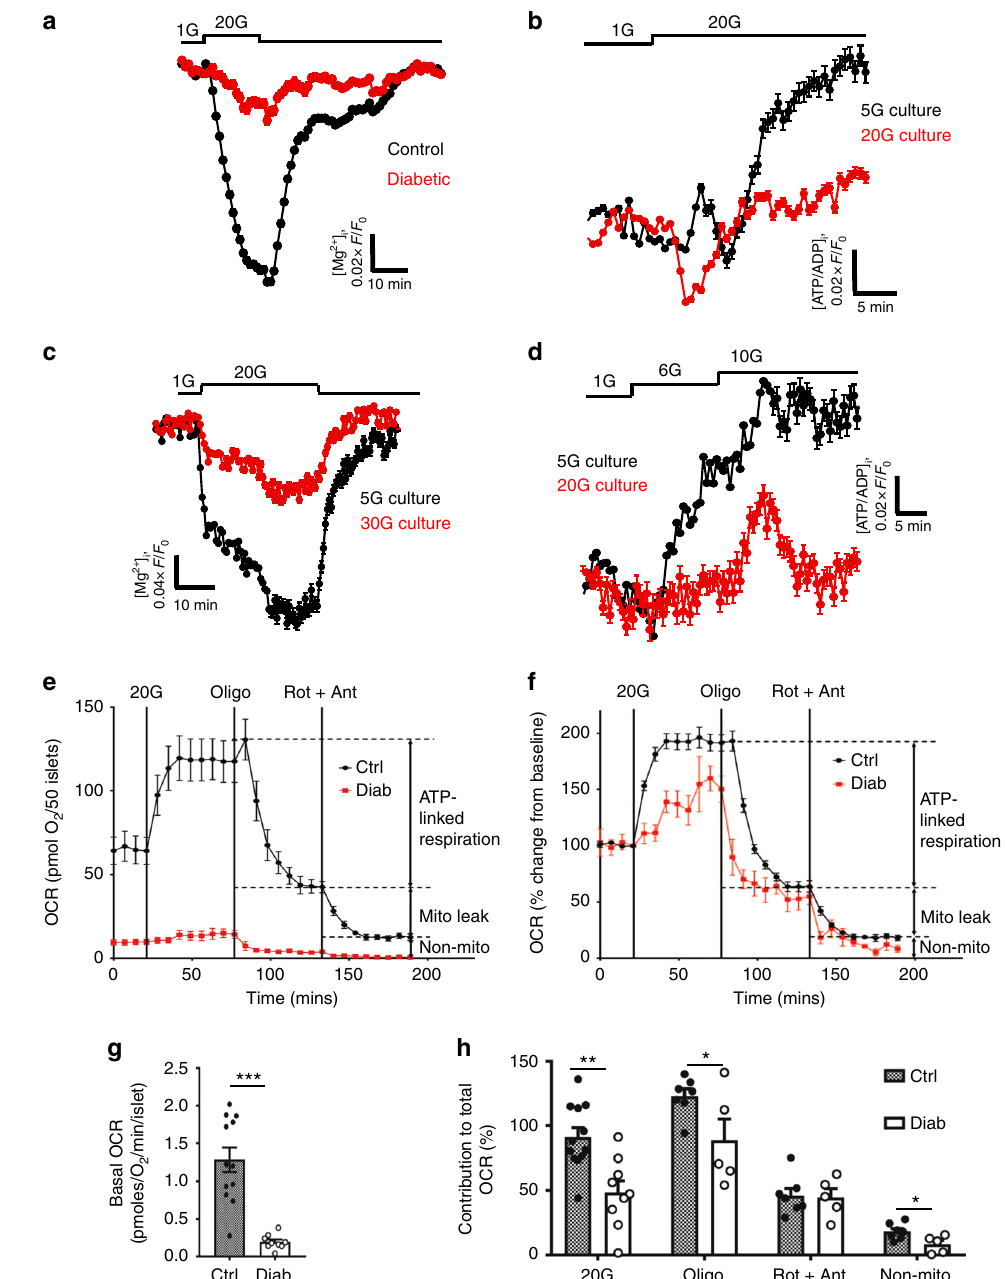
Fig. 5 Hyperglycaemia alters islet ATP production and mitochondrial ef fi ciency. a , c Change in intracellular ATP, as assessed by the reduction in intracellular Mg 2 + (measured using Mg-green) in response to 20 mM glucose. Data are mean ± s.e.m. a Control (black, n = 1147 islets) and 2-week diabetic β V59M mouse islets (red, n = 423 islets). c Control mouse islets cultured at 5 mM (black, n = 1228) or 30 mM (red, n = 423) glucose for 48 h. b , d Change in intracellular ATP/ADP ratio (Perceval fl uorescence). Data are mean ± s.e.m. b In response to 20 mM glucose in control mouse islets cultured for 48 h at 5 mM glucose (black, n = 288 islets) or 20 mM glucose (red, n = 267 islets). d . In response to 6 and 10 mM glucose in non-diabetic human islets cultured for 72 h at 5 mM (black, n = 157) or 20 mM (red, n = 318) glucose. e Oxygen consumption rate (OCR) of control (black) and 2-week diabetic (red) islets at 2 mM glucose and after sequential addition of 20 mM glucose, 5 μ M oligomycin and 5 μ M rotentone + 5 μ M antimycin A. Data points are mean ± s.e.m. (Control, n = 7 – 12 replicates (of 50 islets); Diabetic, n = 5 – 9 replicates (of 50 islets) with 6 animals/genotype). f OCR of control (black) and 2-week diabetic (red) islets normalised to percentage of baseline, at 2 mM glucose and after sequential addition of 20 mM glucose, 5 μ M oligomycin and 5 μ M rotentone + 5 μ M antimycin A. Data points are mean ± s.e.m. Same data as in e (Control, n = 7 – 12 replicates (of 50 islets); Diabetic, n = 5 – 9 replicates (of 50 islets) with 6 animals/genotype). g Basal OCR at 2 mM glucose (basal OCR) of control (hatched) and 2-week diabetic (white) islets. Control, n = 12 replicates; diabetic n = 9 replicates; 6 animals/genotype. Data points are mean ± s.e.m. *** p < 0.001. Same data as in e . h Percentage of change in OCR when glucose was raised from 2 to 20 mM (20G), ATP-linked OCR (oligo), OCR required to maintain the mitochondrial leak (rot + ant) and non-mitochondrial OCR (non-mito) in control (hatched) and 2-week diabetic (white) islets. 20 G, 20 mM glucose. Oligo, 5 µ M oligomycin. Rot + Ant, 50 µ M rotenone + 5 μ M antimycin A. Control, n = 12 replicates (20G), n = 7 (other compounds). Diabetic, n = 9 replicates (20 G), n = 5 (other compounds). 6 animals/genotype. Same data as in e . Data are mean ± s.e.m. t test * p < 0.05; ** p < 0.01; *** p <